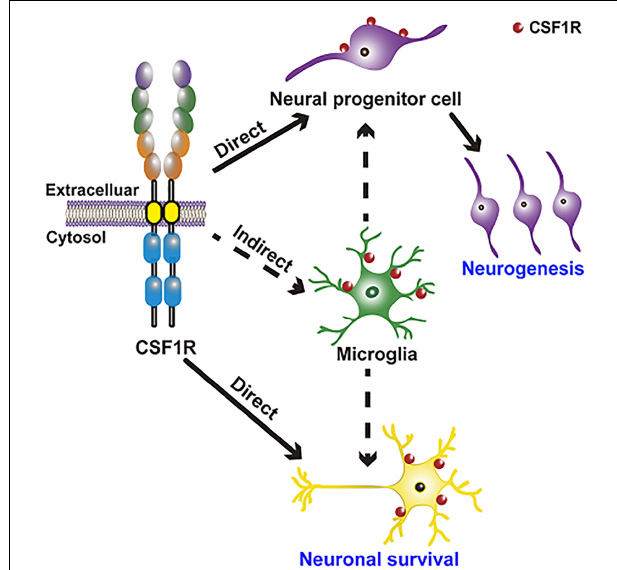
FIGURE 2 | CSF1R regulation of neurogenesis and neuronal survival is achieved in two ways: Direct modulation of NPCs and neurons and indirect modulation through microglia. CSF1R is expressed in NPCs and in a small number of neurons, directly regulating neurogenesis and neuronal survival. CSF1R is also abundantly expressed in microglia, by which can indirectly modulate neurogenesis and the function of